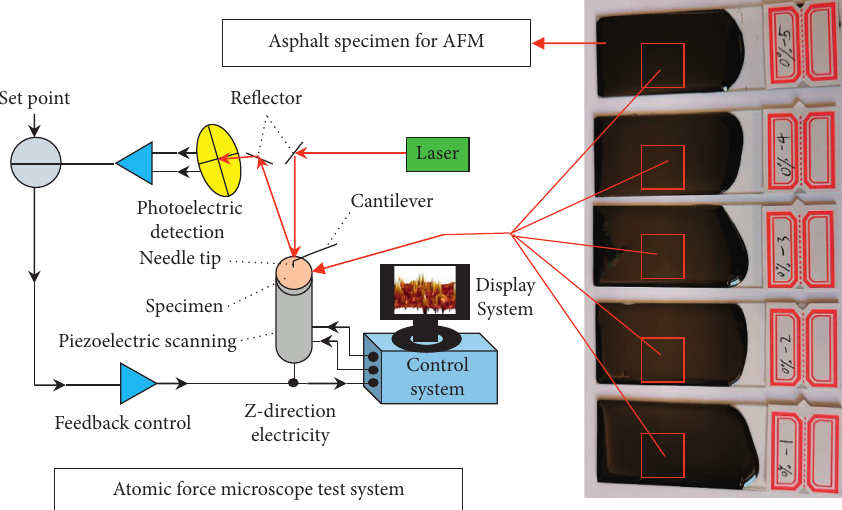
Figure 2: The AFM specimen preparation and test process in this paper.